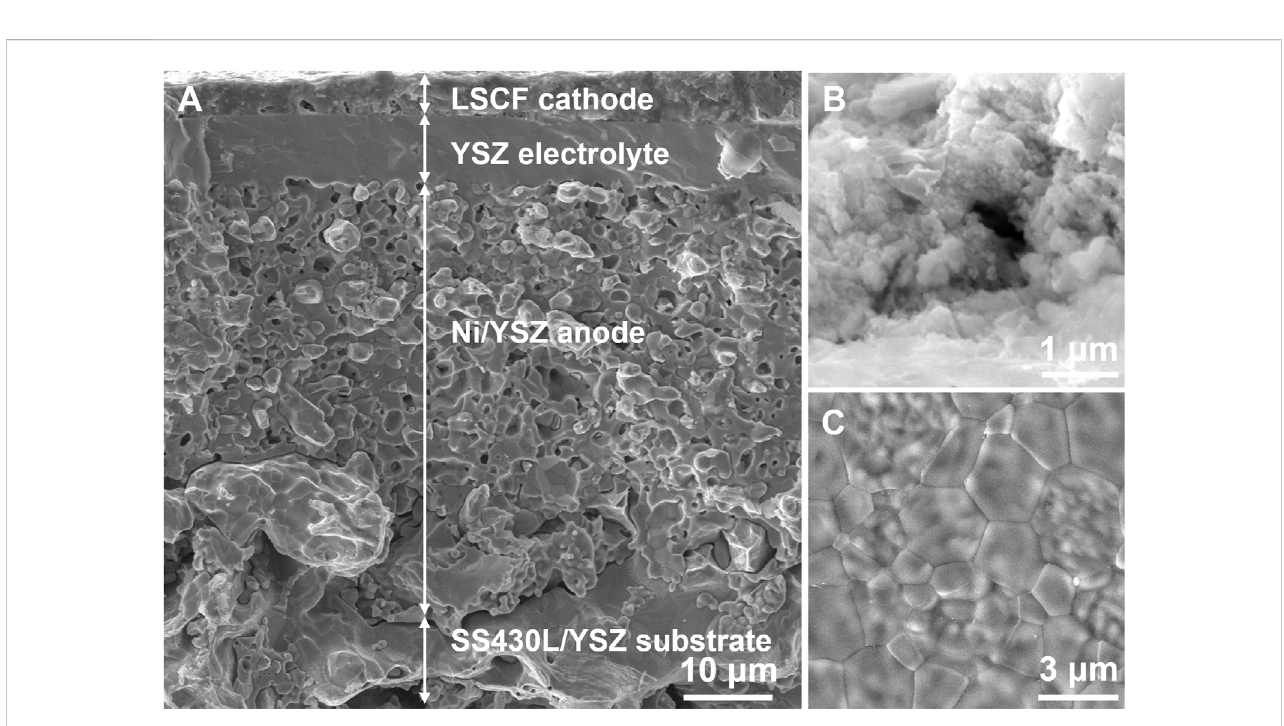
FIGURE 11 SEM images of the following materials: (A) fracture cross section of the MS-SOFC button cell; (B) fracture cross section of the ultrasonic pyrolytic- sprayed LSCF cathode; and (C) surface of the electrolyte.